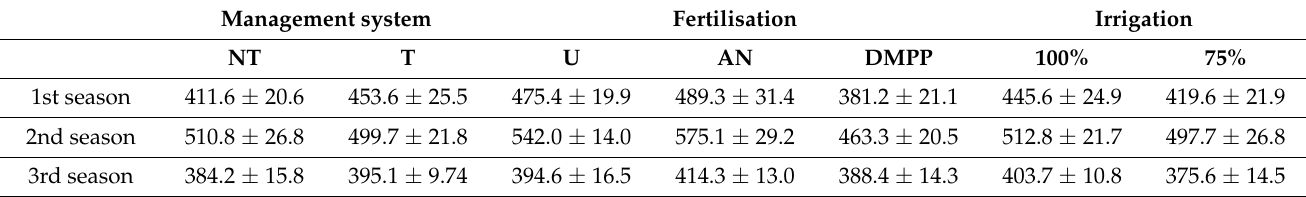
Table 6. Cumulative N 2 O emissions (g N ha − 1 ) for the three studied variables and in all seasons for 180 days ( ± standard